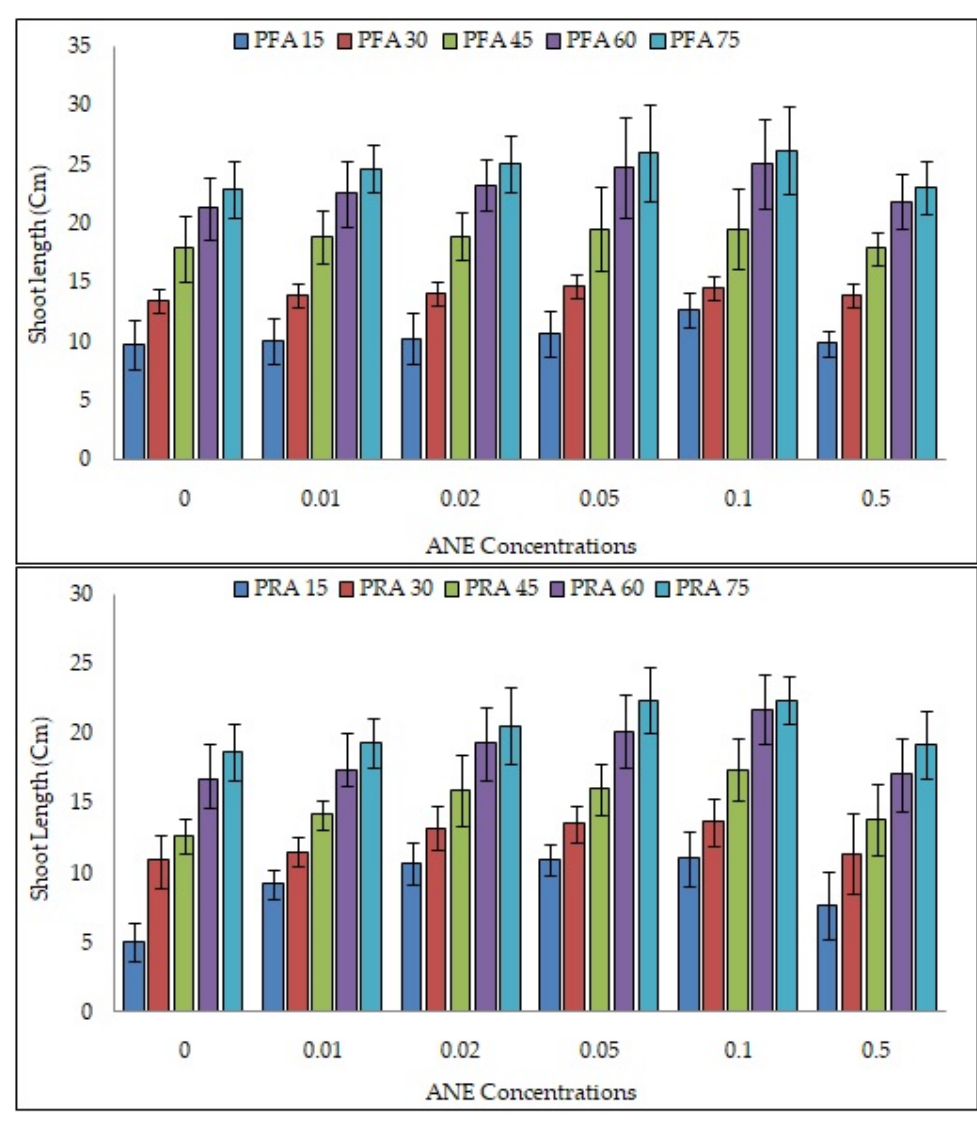
Figure 2. Efficacy of ANE on shoot length after foliar application (PFA) and root application. (PRA) in V. aconitifolia. Bar indicates mean ± SD (n = 3). Table 2. ANOVA for shoot growth at various concentrations of ANE in Vigna aconitifolia